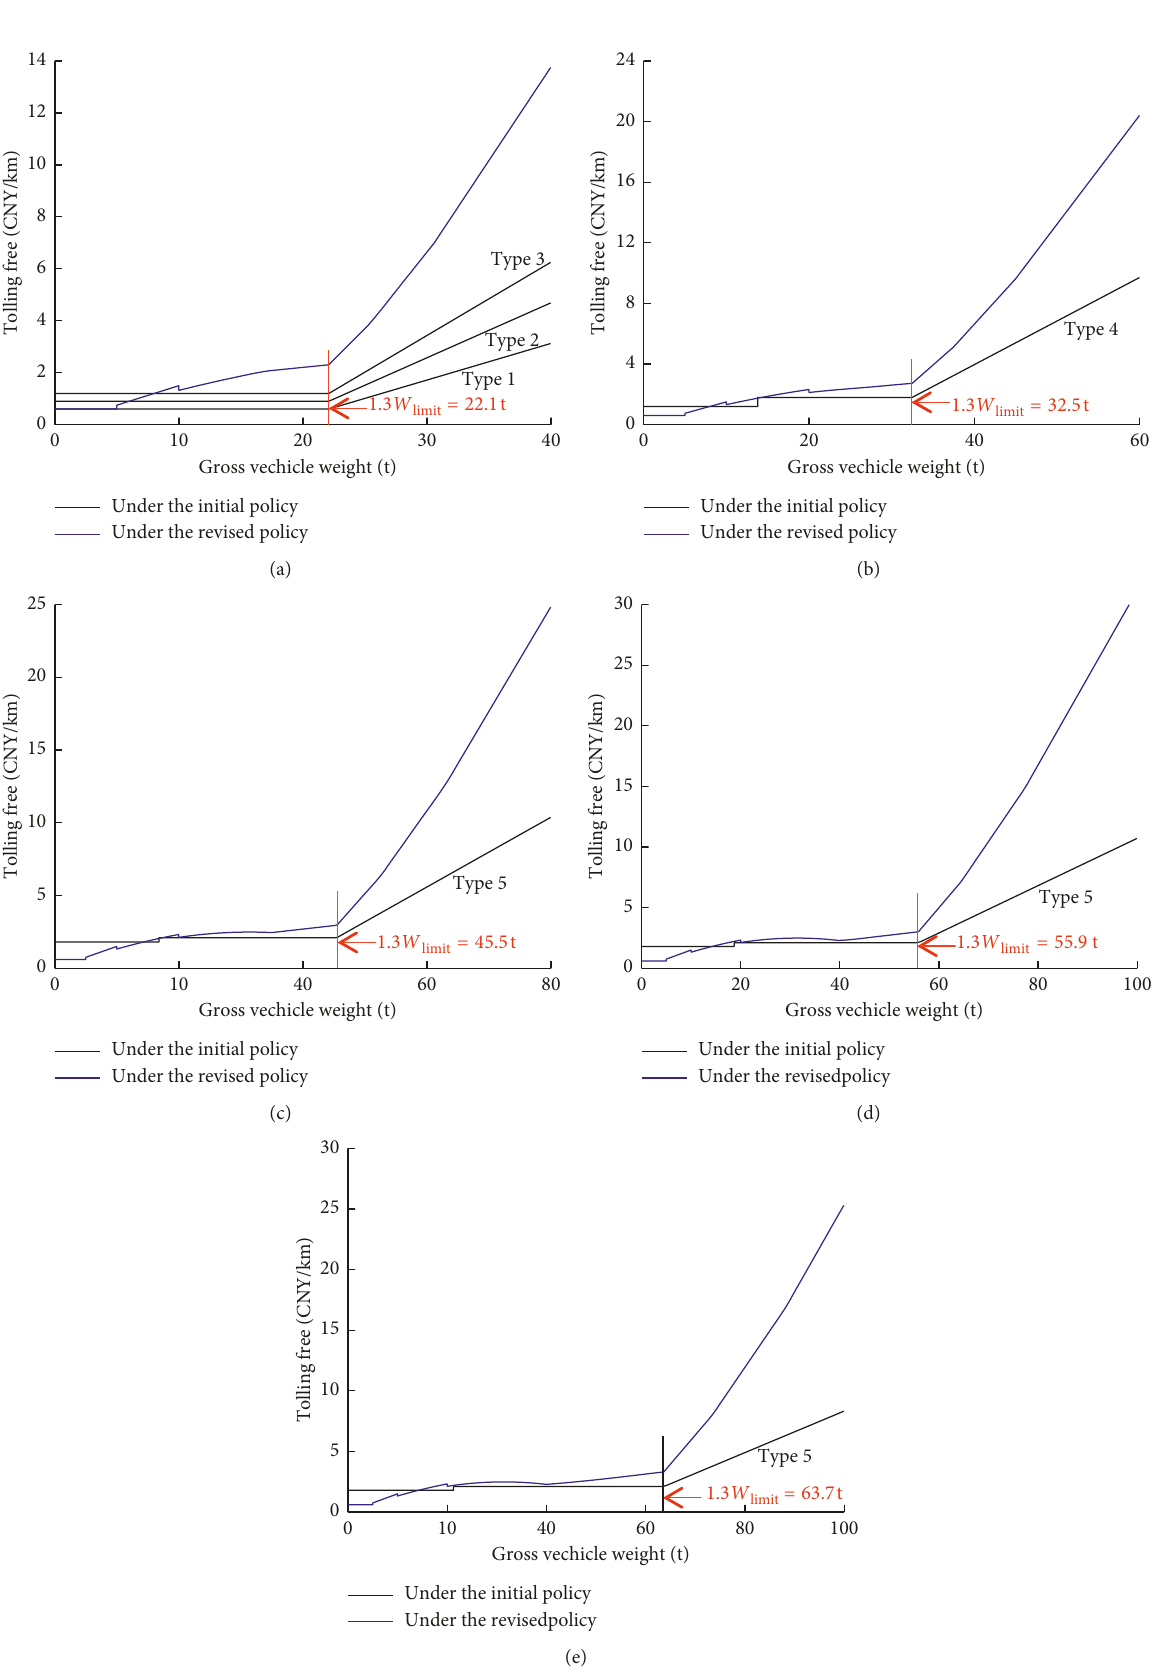
Figure 2: Toll fees under the initial and revised toll-by-weight policies. (a) Two-axle trucks. (b) Three-axle trucks. (c) Four-axle trucks. (d) Five-axle trucks. (e) Six or more-axle trucks. Note: W limit , GVW